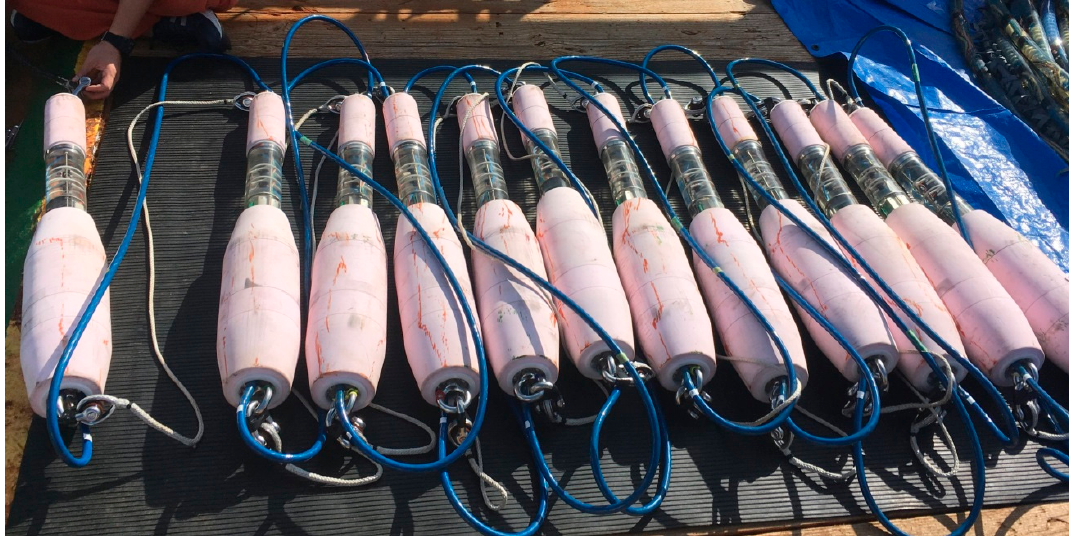
Figure 8. Photograph of 12 catenated acoustic modules with buoyancy materials being prepared for deployment on the ship.